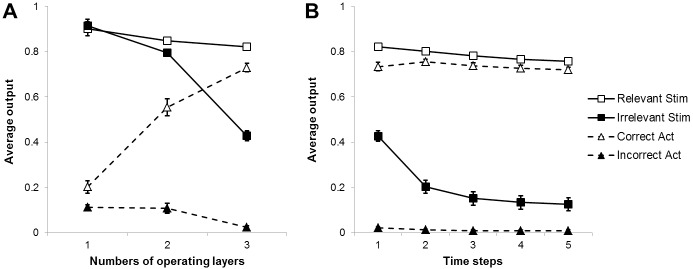
The iterative solution developed by the neural network.(A) Data generated by the network in three test conditions in which only the first, or only the first two, or all three hidden layers were allowed to operate (1, 2, and 3, respectively). (B) Data generated by the network after one to five processing time steps in which the network operated on the basis of its previously self-generated output.